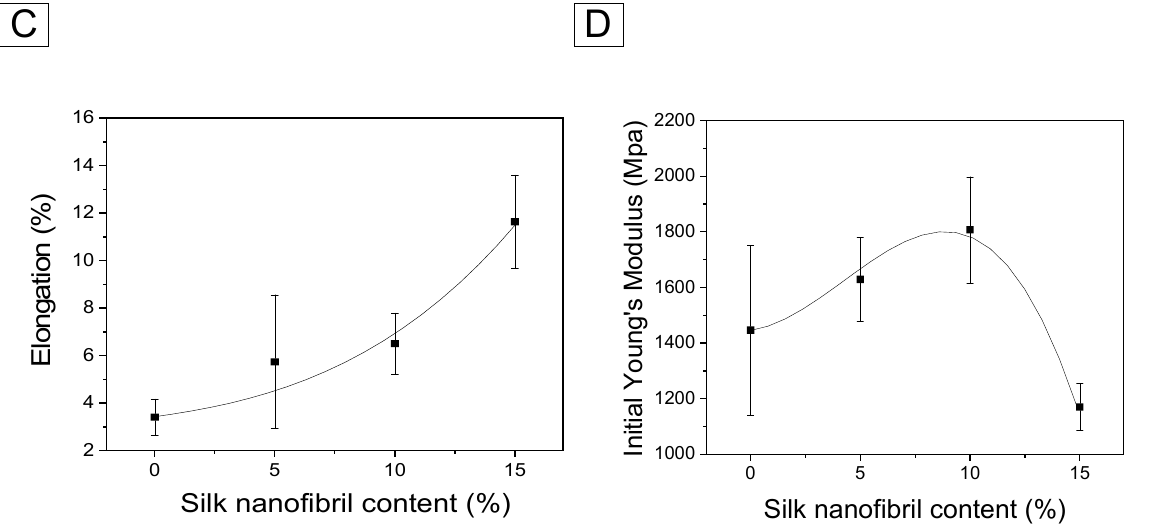
Figure 6. ( A ) Representative stress–strain curve: ( a ) 0%, ( b ) 5%, ( c ) 10%, and ( d ) 15%, ( B )